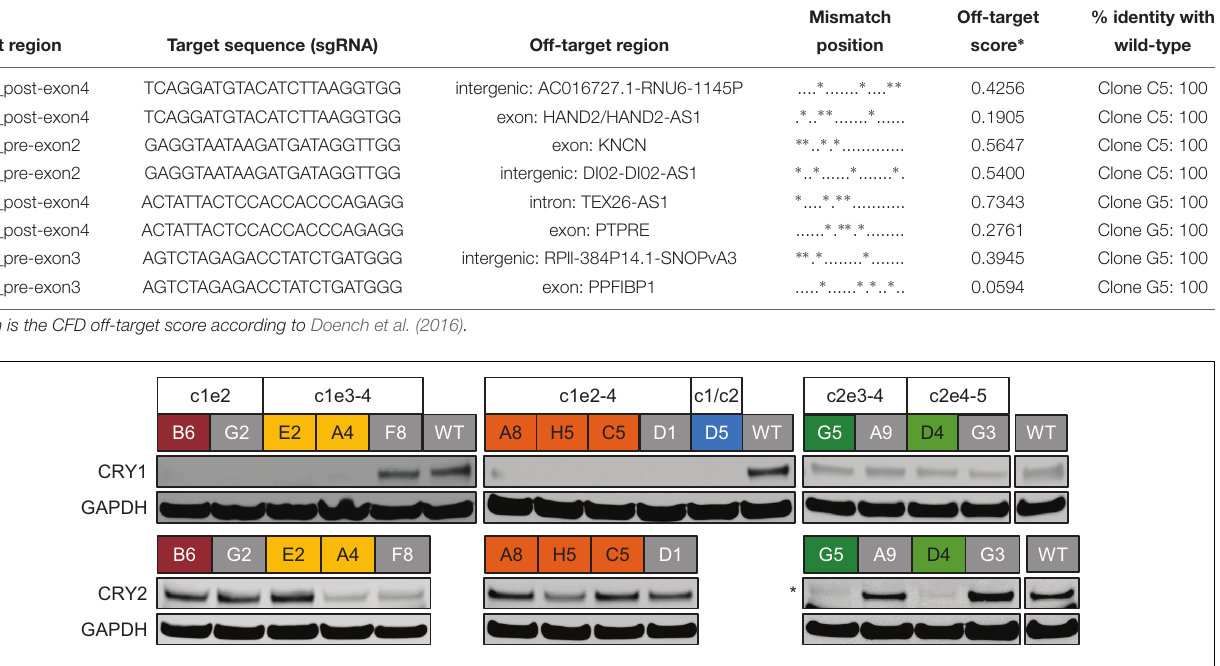
FIGURE 4 | CRY protein levels in CRISPR/Cas9-generated knockout cell clones. Whole cell lysates from indicated single cell clones were analyzed using SDS-PAGE and western blotting. The blots were stained for CRY1 or CRY2 as well as for GAPDH as a loading control. CRY1 / CRY2 double knockout clone D5 (blue) was not analyzed for CRY2 expression, since for its “parental” clone, the CRY2 knockout clone G5 (dark green), we did not detect CRY2 protein. Colored headers indicate the identity of the analyzed clones and their potential genomic deletions. Note, for “gray clones,” we did not detect reduction in relative genomic abundance of target exons (see Figure 2B ). ∗ marks an unspecific band with slightly lower electrophoretic